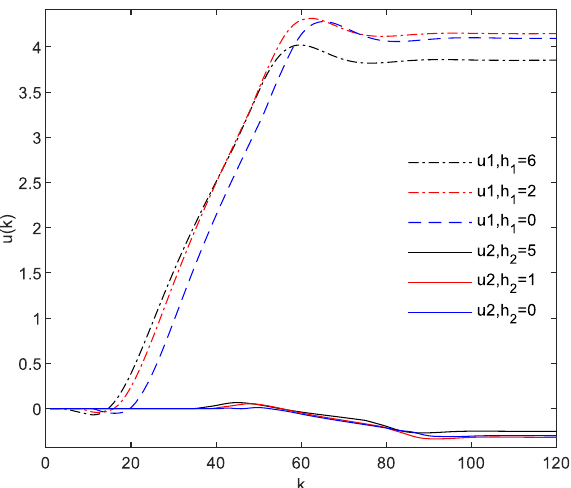
Figure 4. The control input of System (1) with θ 1 = 0 .